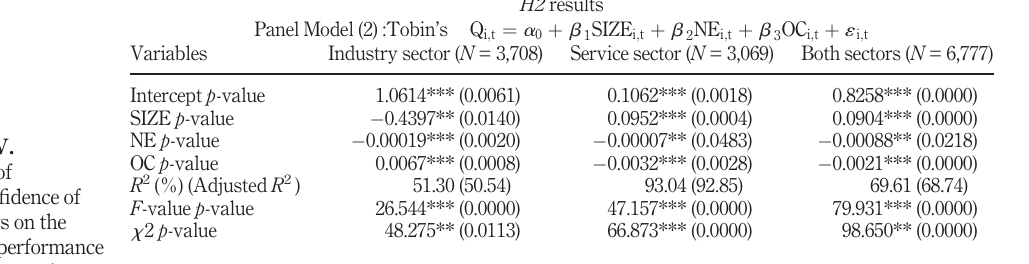
Table V. Impact of overcon fi dence of investors on the market performance of US